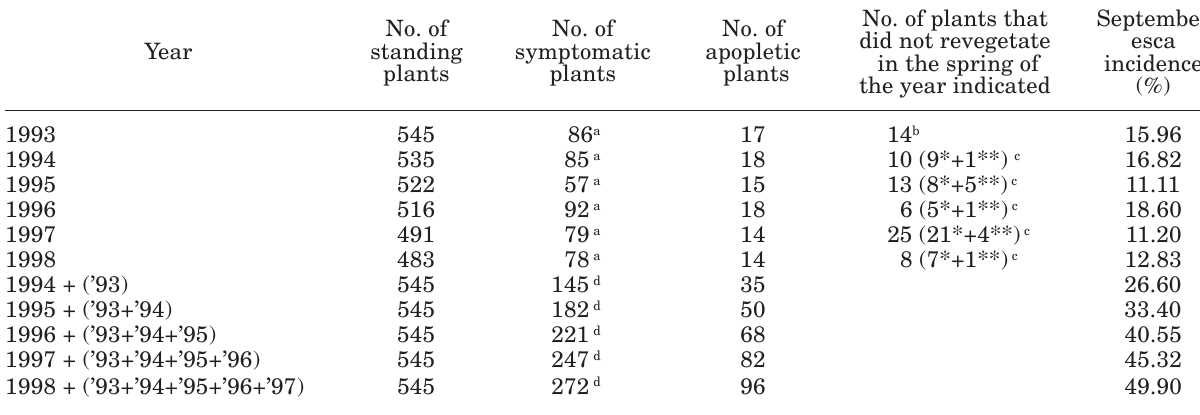
Table 3. Incidence of esca in a vineyard at Gambassi Terme (Florence), from 1993 to 1998. No. of No. of No. of Year standing symptomatic apopletic plants plants plants